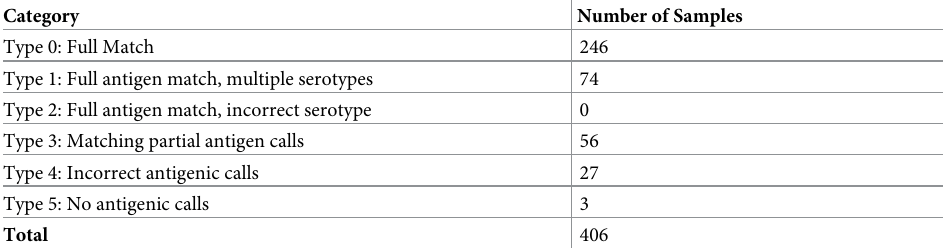
Table 3. A panel of 406 isolates were analyzed using the SGSA v. 2 to determine the performance of the wet-lab assay. Serotype predictions were compared to the phenotypically reported serotype and grouped into one of six